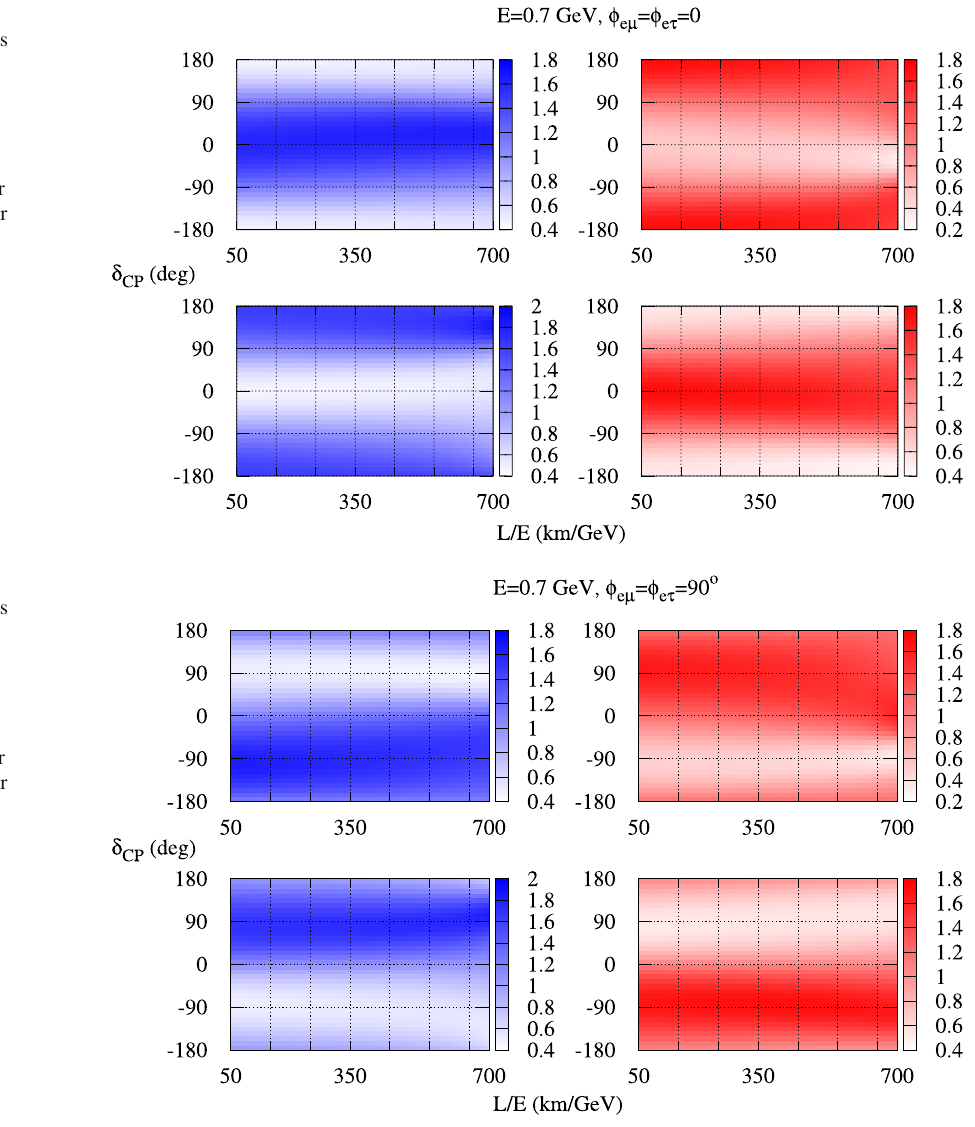
Fig. 7 Ratio of the LIV to standard oscillation probabilities as a function of L / E and δ CP